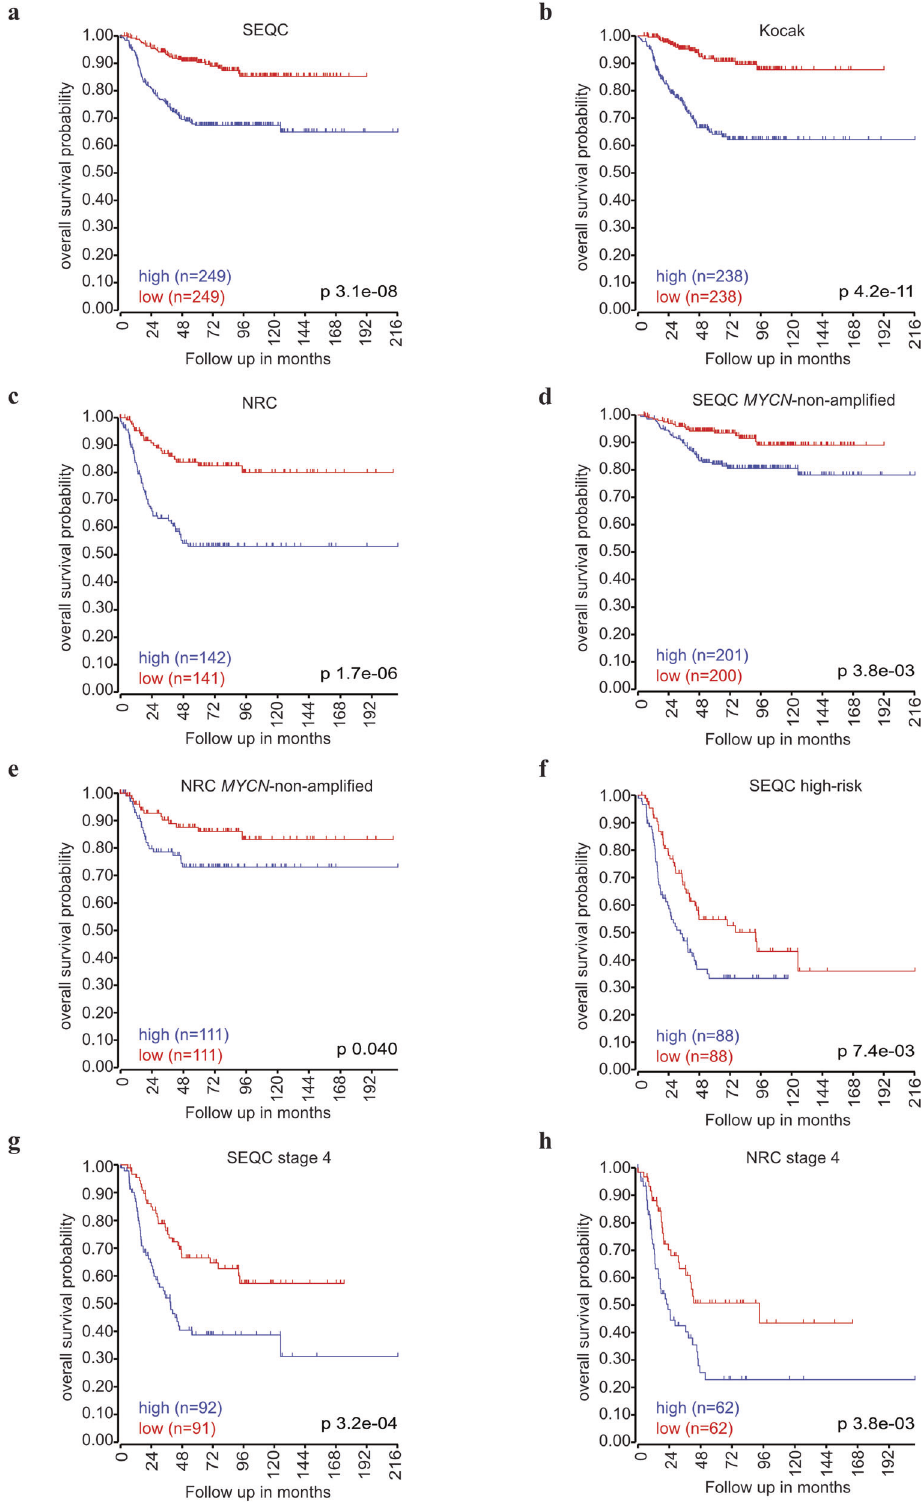
Fig. 2 EIF4EBP1 mRNA expression correlates with overall survival in NB patients. a – c Kaplan – Meier survival estimates of overall survival of NB patients strati fi ed by their EIF4EBP1 mRNA expression levels (median cut off) in the SEQC ( a ), Kocak ( b ), and NRC ( c ) cohorts. d – h Kaplan – Meier survival estimates of overall survival of patients with MYCN -non-ampli fi ed NB ( d , e ), high-risk NB ( f ), or stage 4 NB ( g , h ) strati fi ed by their EIF4EBP1 mRNA expression levels in the indicated NB cohorts. Signi fi cance was determined by log-rank test. Data were obtained from the R2: Genomics Analysis and Visualization Platform.